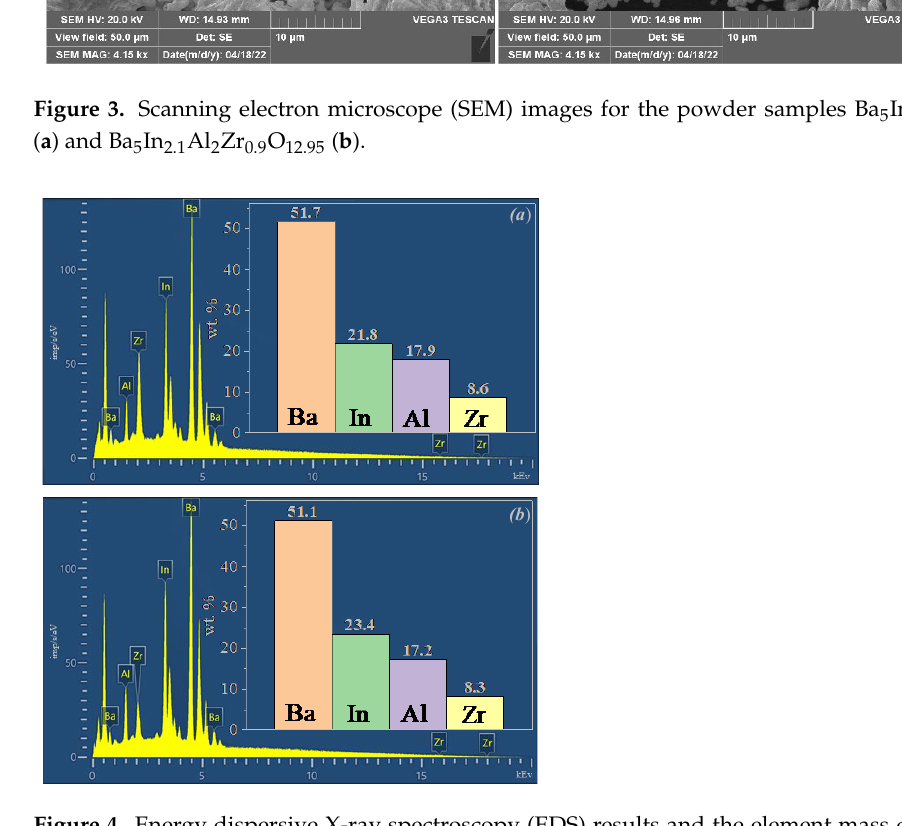
Figure 4. Energy dispersive X-ray spectroscopy (EDS) results and the element mass distribution histograms (at.%) for Ba 5 In 2 Al 2 ZrO 13 ( a ) and Ba 5 In 2.1 Al 2 Zr 0.9 O 12.95 ( b ). Table 1. Elemental composition determined by the EDS for the samples Ba 5 In 2 Al 2 ZrO 13 and Ba 5 In 2.1 Al 2 Zr 0.9 O 12.95 . Theoretical Values, Compound